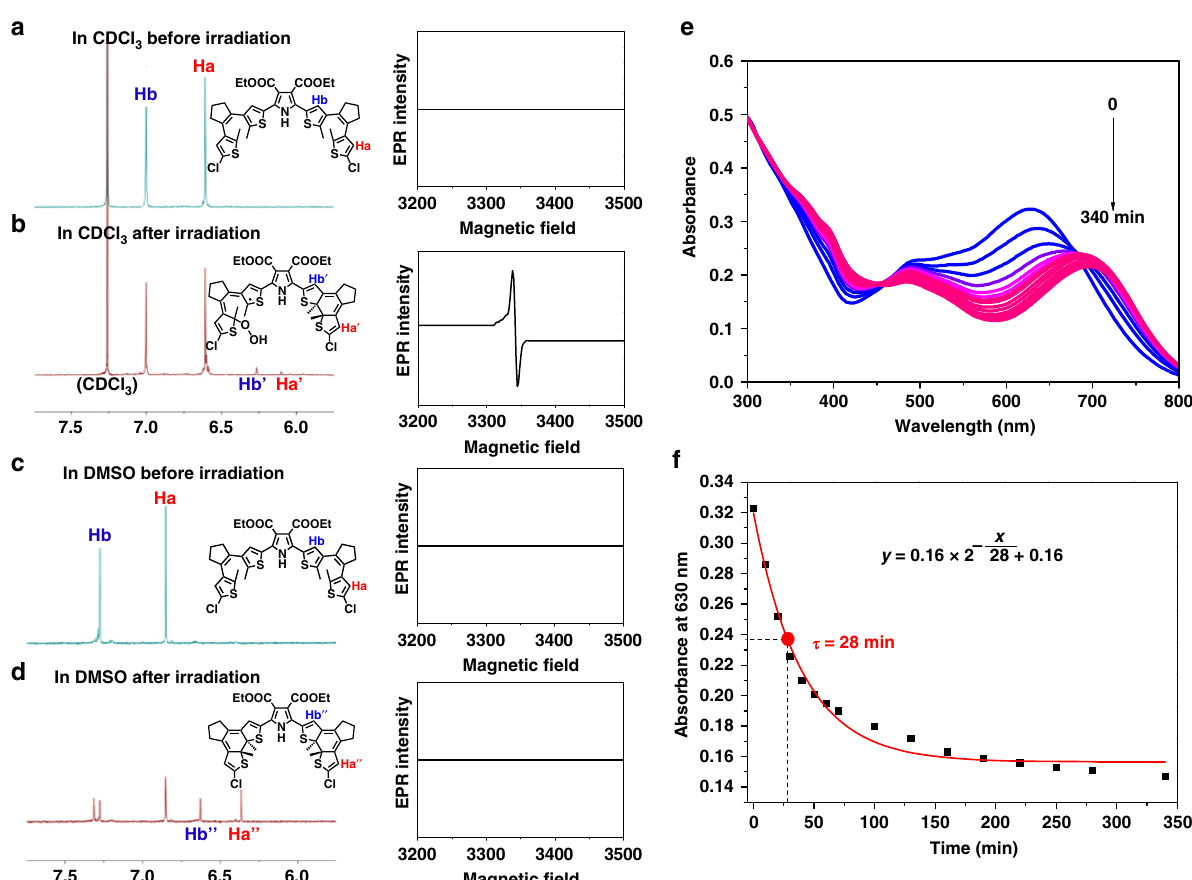
Fig. 3 Characterization for the radical species. a – d 1 H NMR spectra of compound 1 in CDCl 3 and DMSO- d 6 and the corresponding EPR spectra without and with irradiation of 365 nm light at 25 °C, respectively. e UV – vis absorption spectral changes and f the decay curve of compound 1 (1.0 × 10 − 5 M) in oxygen-saturated CHCl 3 solution after withdrawing the